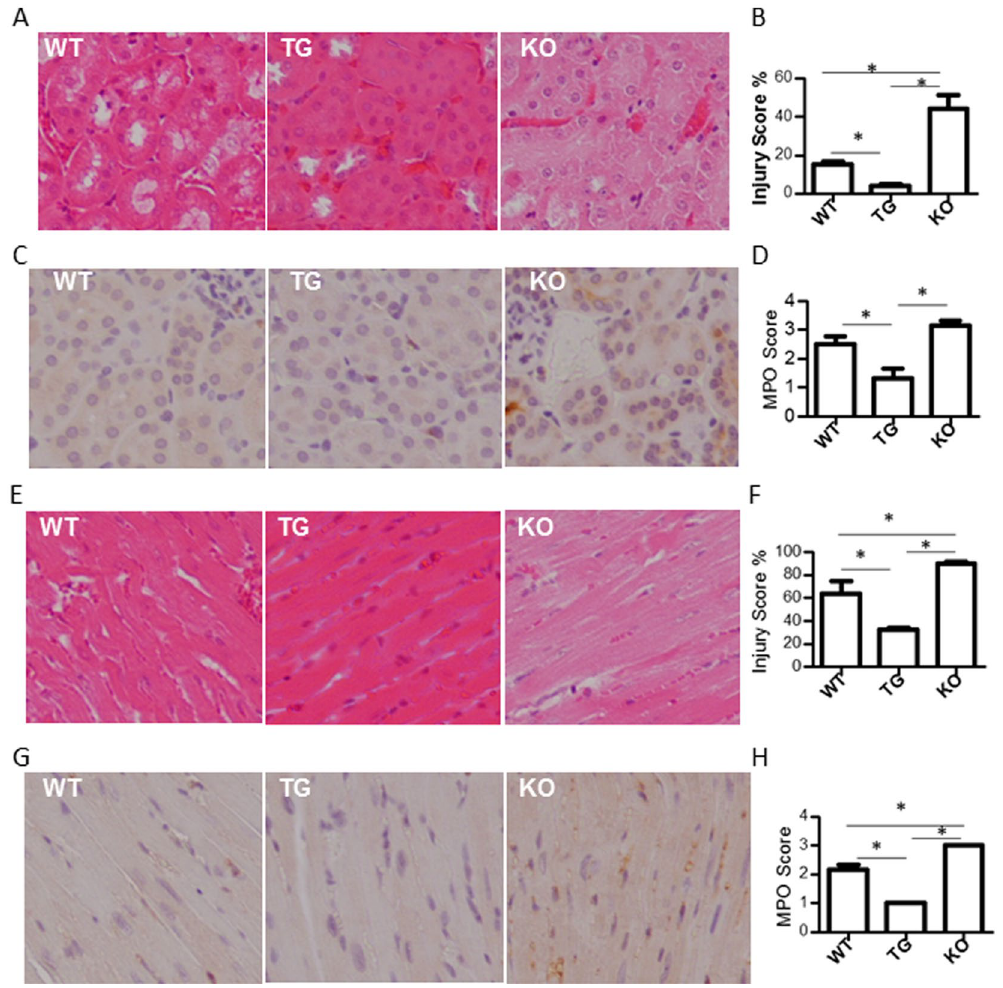
Figure 2. GDF15 KO mice show greater levels of tubular damage and cardiac injury, and increased neutrophil infiltration. Sixteen hours after LPS treatment, kidneys and hearts were harvested from mice. Tissues from all groups were sectioned and stained with H&E and detected MPO activity. Images were taken from kidney cortex at 200 X magnification. ( A ) Representative HE staining images of kidney tissues. ( B ) Injury score for kidney tissues. ( C ) Representative MPO images of kidney tissues. ( D ) MPO score for kidney tissues. ( E ) Representative HE staining images of heart tissues. ( F ) Injury score for heart tissues. ( G ) Representative MPO images of heart tissues. ( H ) MPO score for heart tissues. n = 6 for HE staining. n = 4 for MPO assays. * P ≤